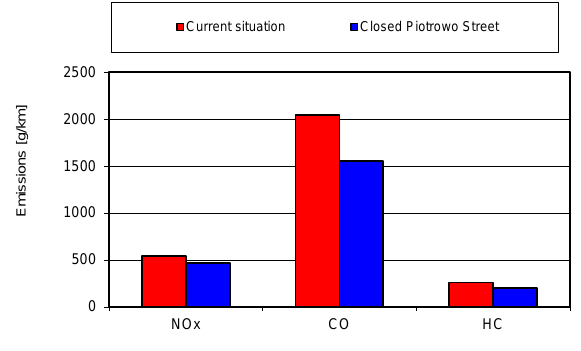
Fig. 10. Emissions of vehicles in the afternoon peak at Baraniaka